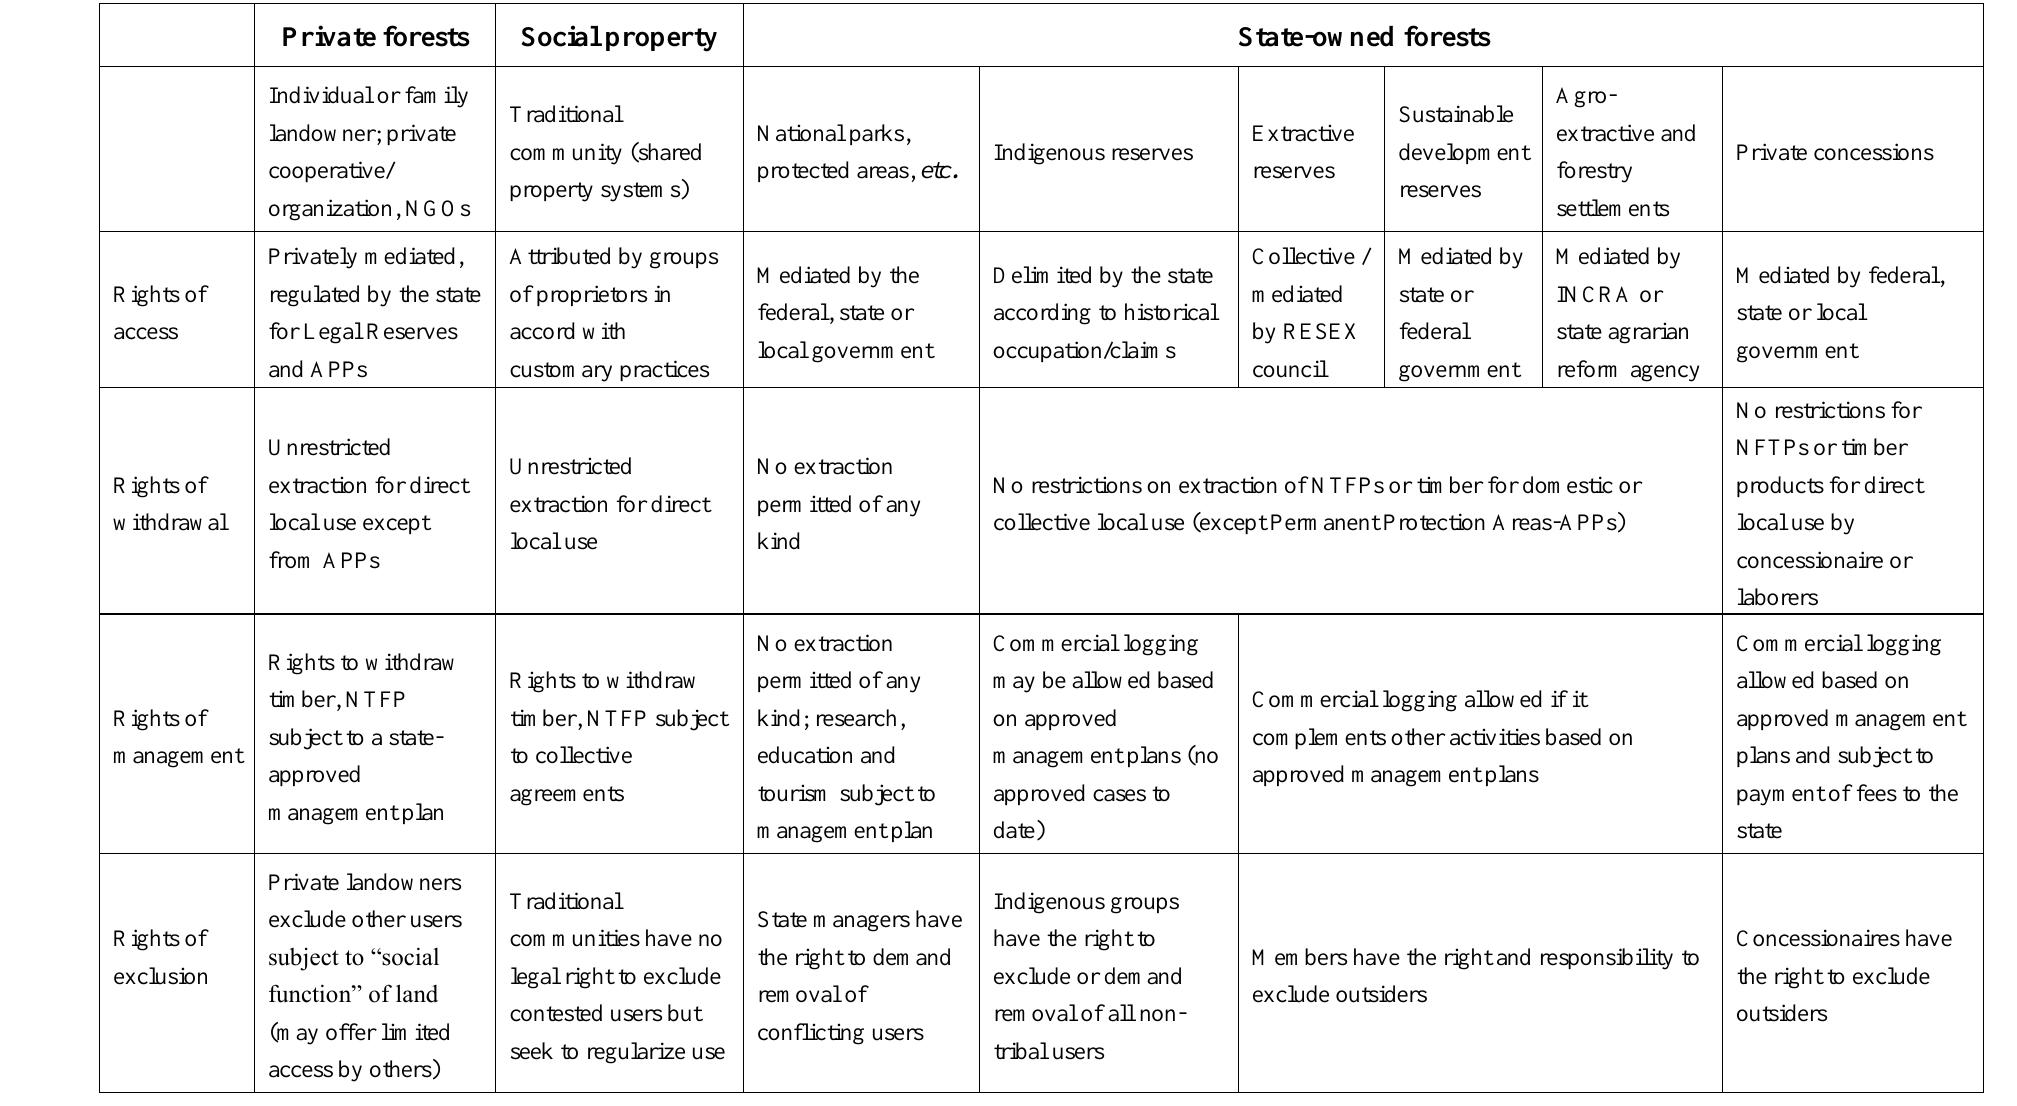
Table 4. Forest tenure systems in Brazil—―Bundles of rights‖ and implications for REDD+ design and